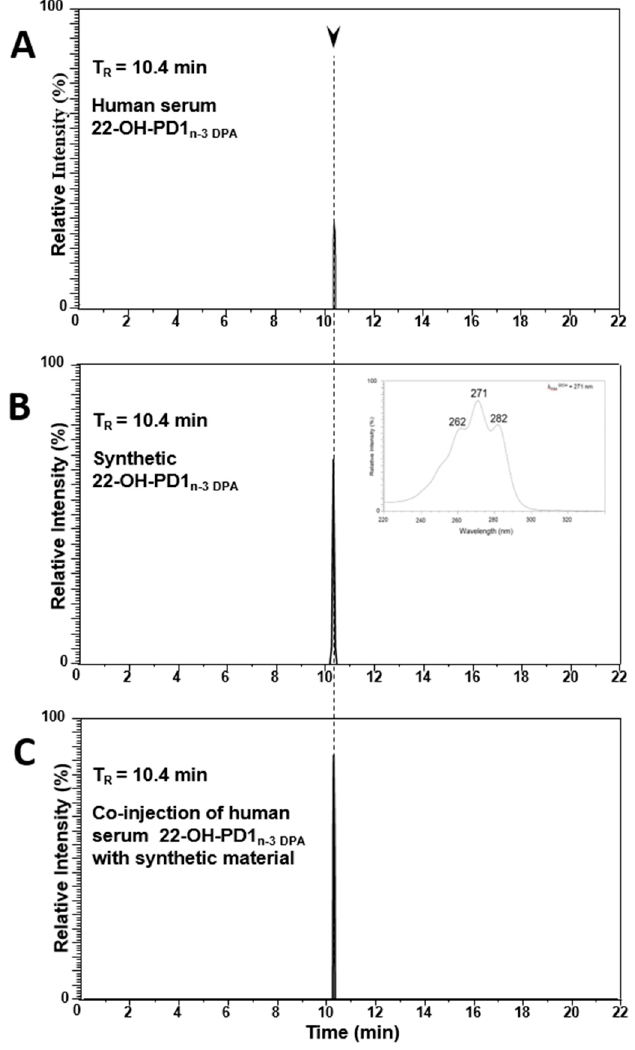
Figure 3. Multiple reaction monitoring (MRM) chromatogram of the products from ( A ) endogenous 22-OH-PD1 n-3 DPA ( 5 ) produced in human serum; ( B ) synthetic material of 5 ; ( C ) co-injection of endogenous and synthetic material.